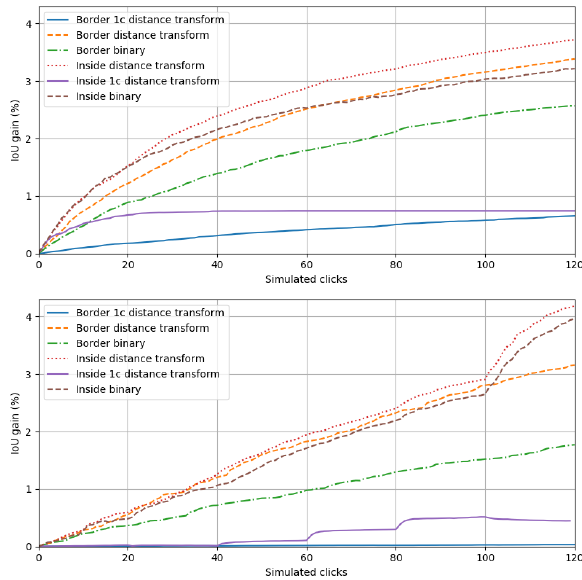
Figure 6. Comparison of the different annotation strategies on the INRIA (top) and Potsdam (bottom) datasets. 1c means single annotation